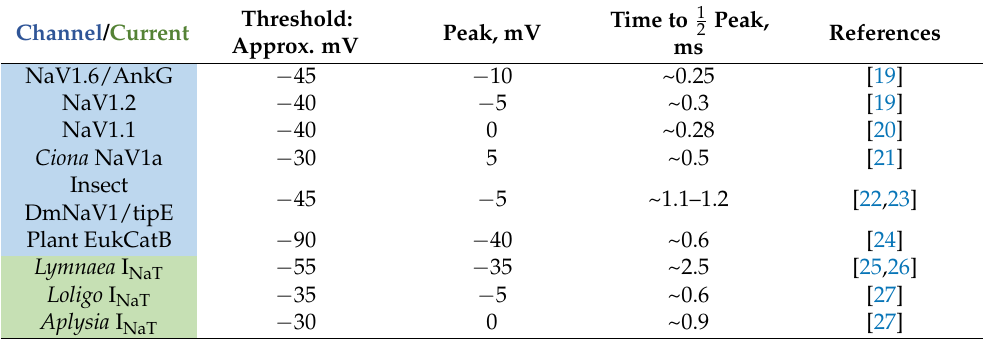
Table 1. Electrical characteristics of NaV channels cloned into heterologous expression systems in situ (blue panel) and physiologically dissected transient Na+ currents (I NaT s) of molluscan neurons (green panel) obtained using the voltage-clamp technique. The voltage characteristics of activation threshold and peak current, as well as times-to-halfpeak (the length of time it takes to reach half-peak activation) are shown. Voltage values obtained in patch-clamp experiments might contain errors due to liquid junction